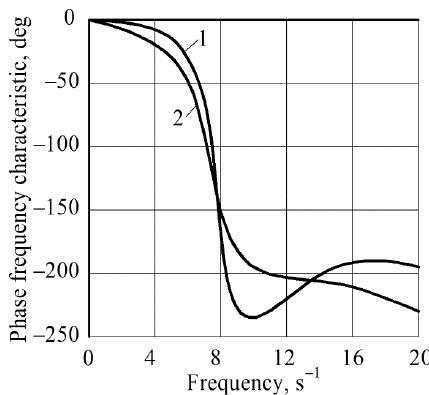
Figure 9. The phase–frequency characteristic of angle ϕ during the processing of the disturbing impact at various values of speed V o : 1—1 m ∙ s − 1 ; 2—3 m ∙ s − 1 .